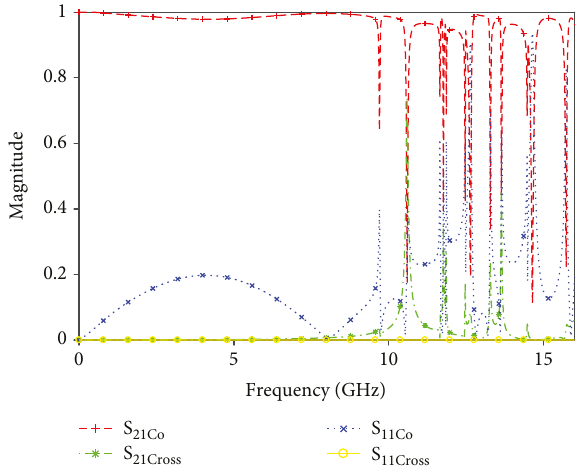
Figure 3: Scattering parameters (magnitude) for a linearly polarized plane wave, normally incident on a structure as shown in Figure